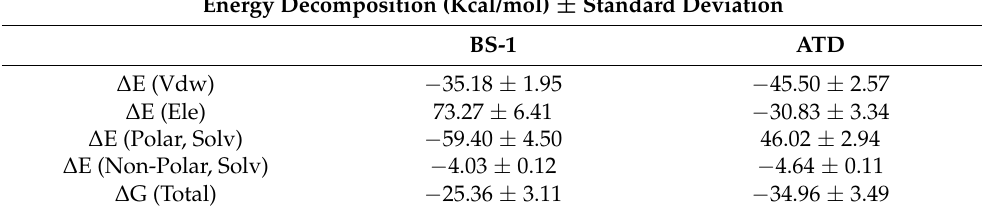
Table 5. BindingfreeenergycalculationsextractedfromthesingletrajectoryofMDSanalysesofthe3ZKBL- BS-1 and 3ZKBL-ATD complexes. The analyses were performed with gmx-MMPBSA-1.5.4 software. Energy Decomposition (Kcal/mol) ± Standard Deviation BS-1 ATD ∆ E